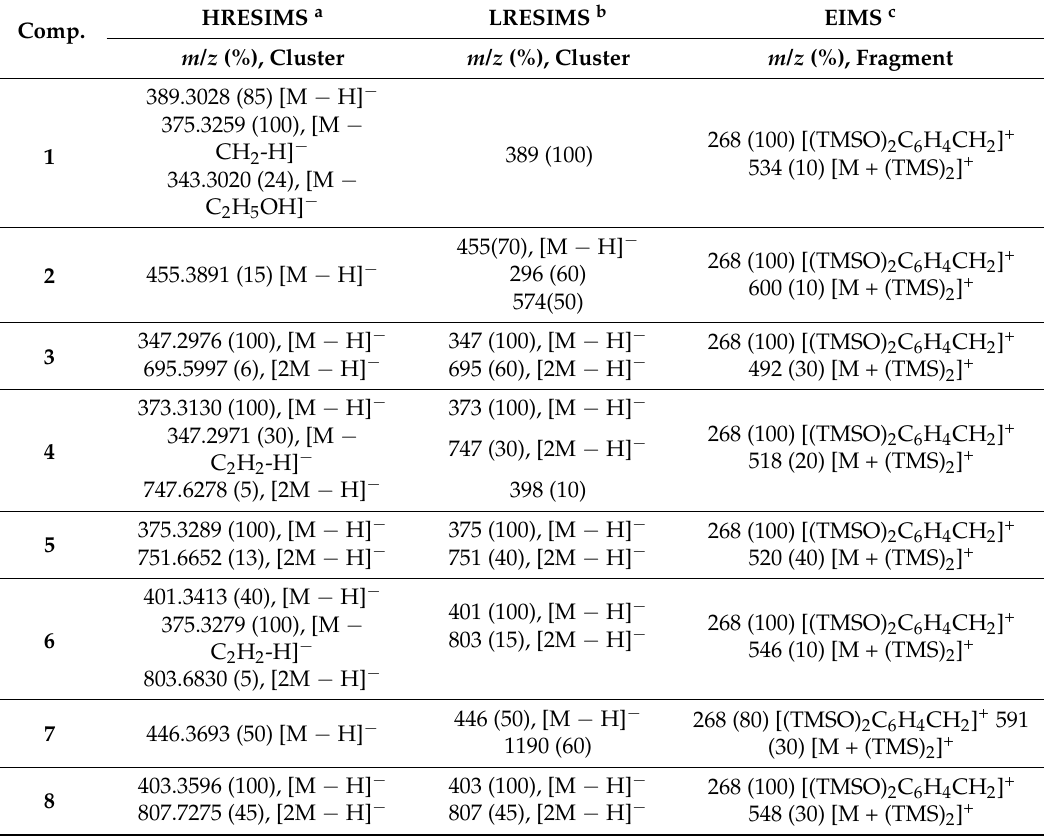
Table A1. MS-based analyses of compounds 1 – 12 using three MS detectors coupled to